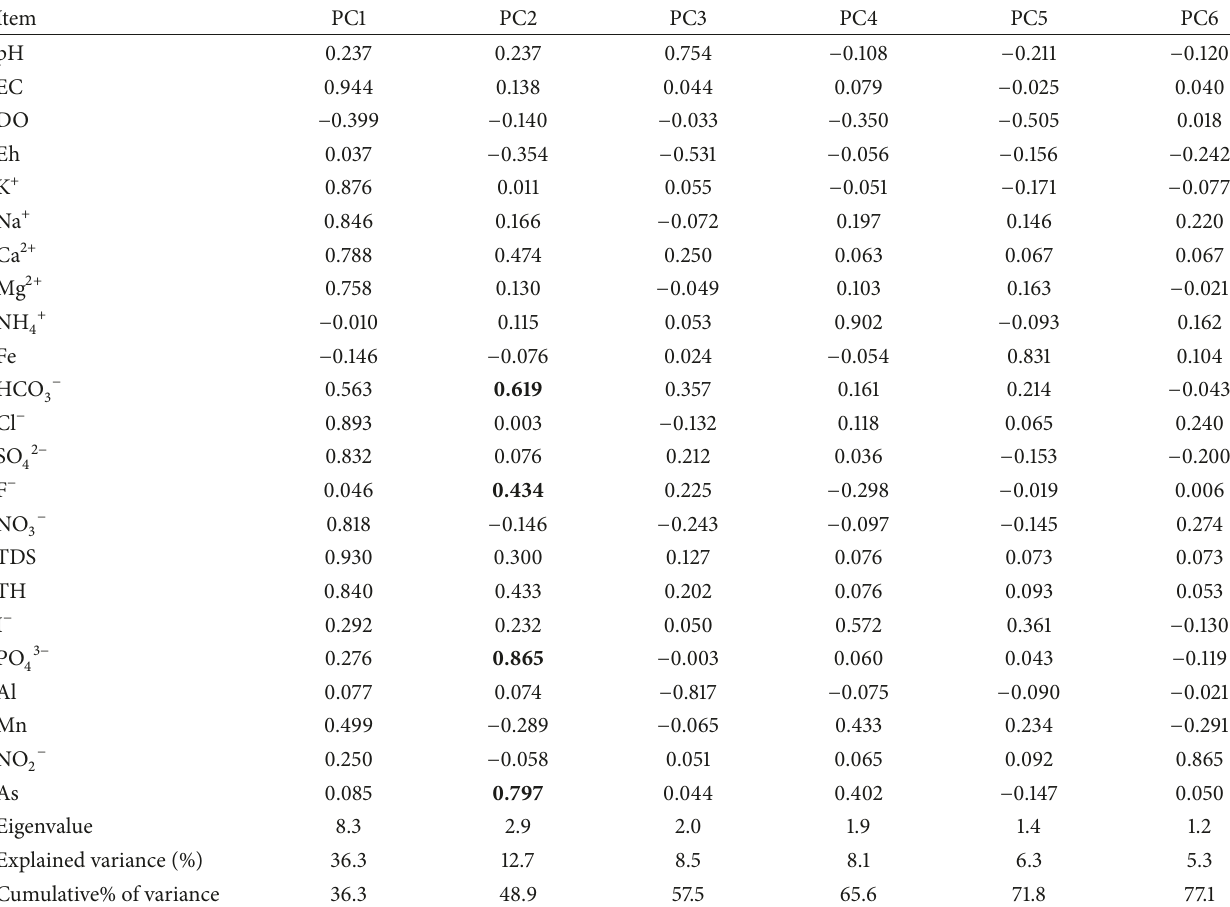
Table 3: Principal component loadings for groundwater samples in fissured